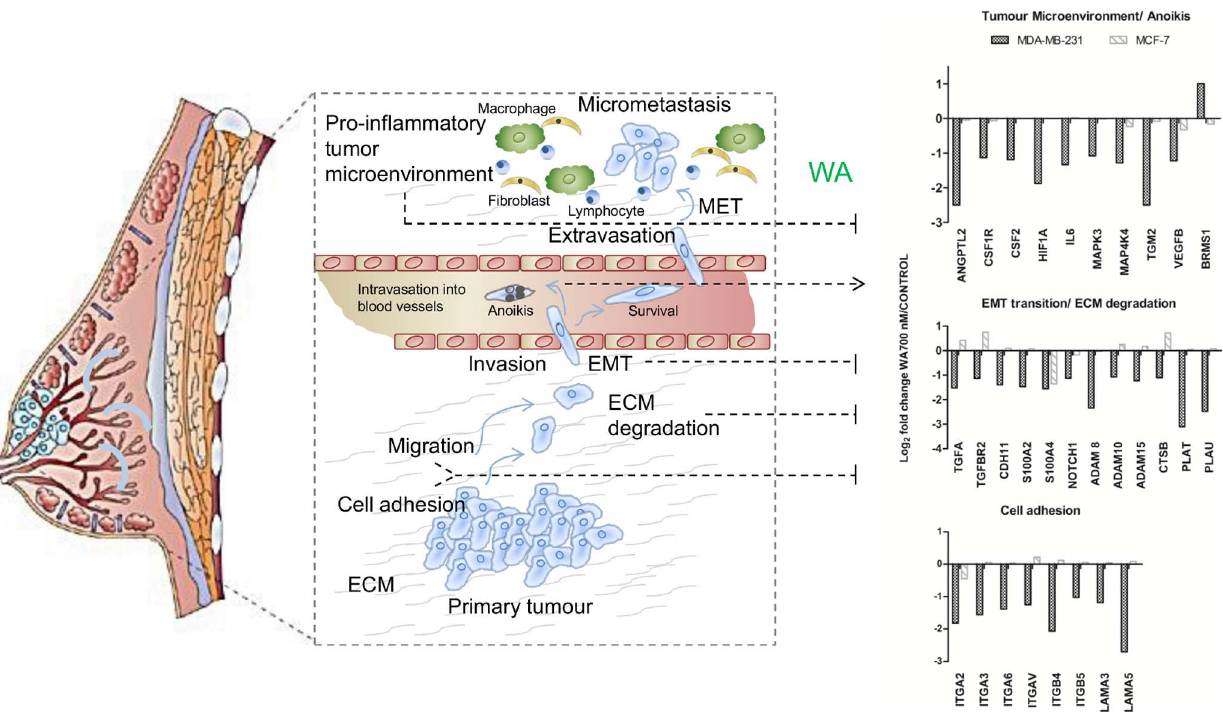
Figure 4. Impact of WA on several essential steps of the metastatic cascade in MDA-MB-231 cells. Graphics is a modified version of Figure 1 from [65]. Bar graphs represent mean log 2 fold change from three independent experiments of metastasis target gene expressions of 700 nM WA-treated MDA-MB-231 and MCF-7 cells relative to non-treated control samples as determined by Human HT-12 v4 BeadChip Gene Expression